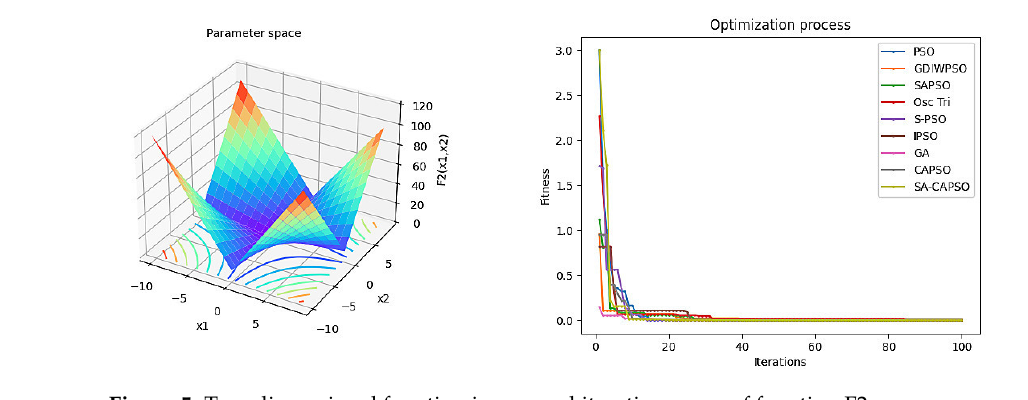
Figure 5. Two-dimensional function image and iterative curve of function F2.